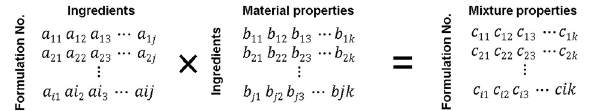
Figure 1. Prediction of formulation properties based on the ideal mixing